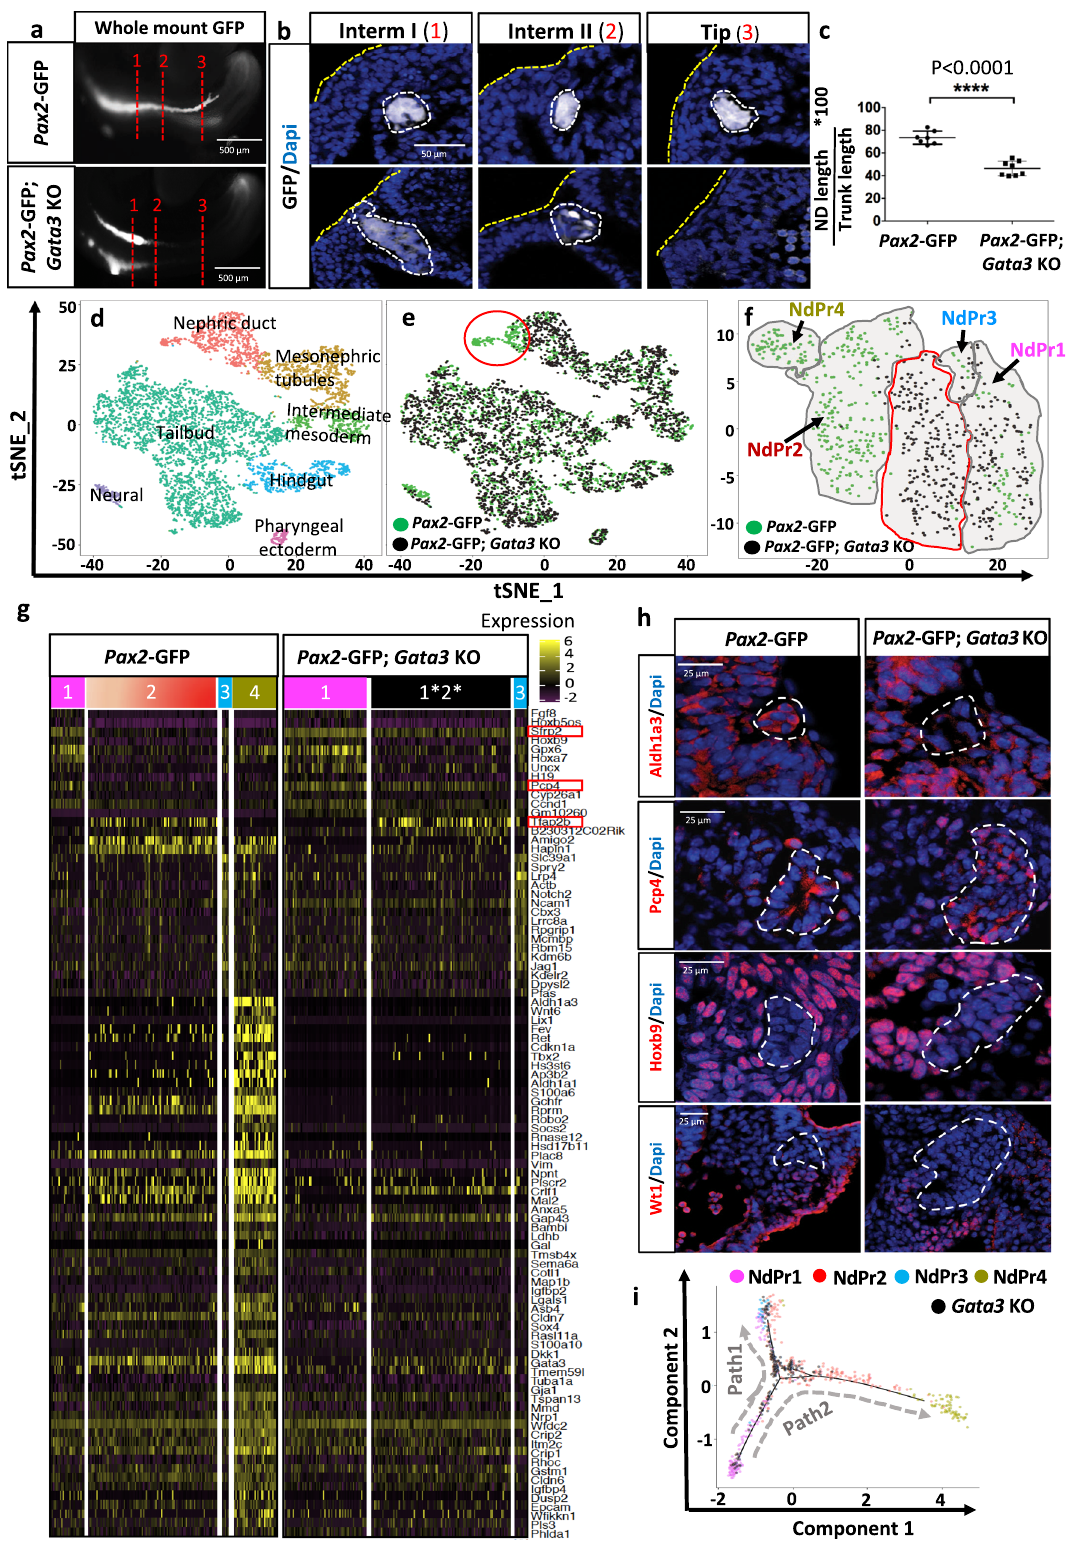
plays these important roles are not well understood. This report demonstrates that Gata3 functions in ND development by controlling progenitor cell lineage progression. Most notably, Gata3 de fi cient embryos lack the NdPr4 cell fate from which the UB forms. Interestingly, NdPr3 is still speci fi ed in the mutant, suggesting that Gata3 may act speci fi cally on the